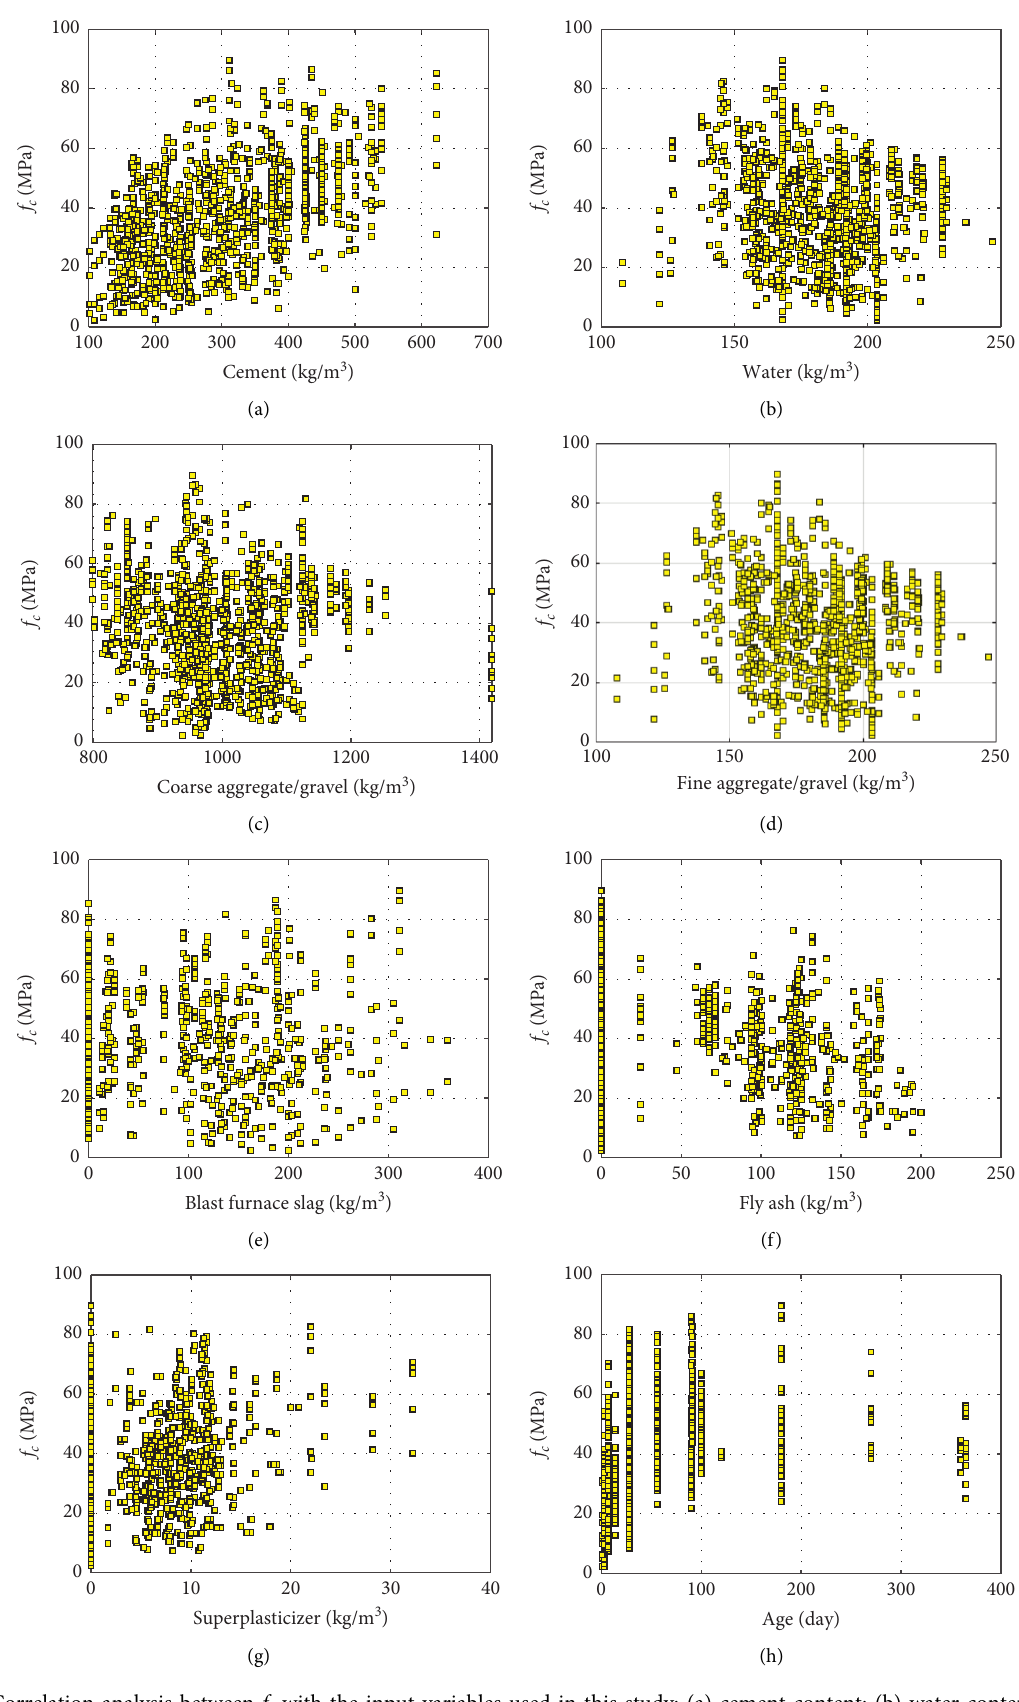
Figure 1: Correlation analysis between f c with the input variables used in this study: (a) cement content; (b) water content; (c) coarse aggregate or gravel content; (d) fine aggregate or sand content; (e) blast-furnace slag content; (f) fly ash content; (g) superplasticizer content; and (h) age of